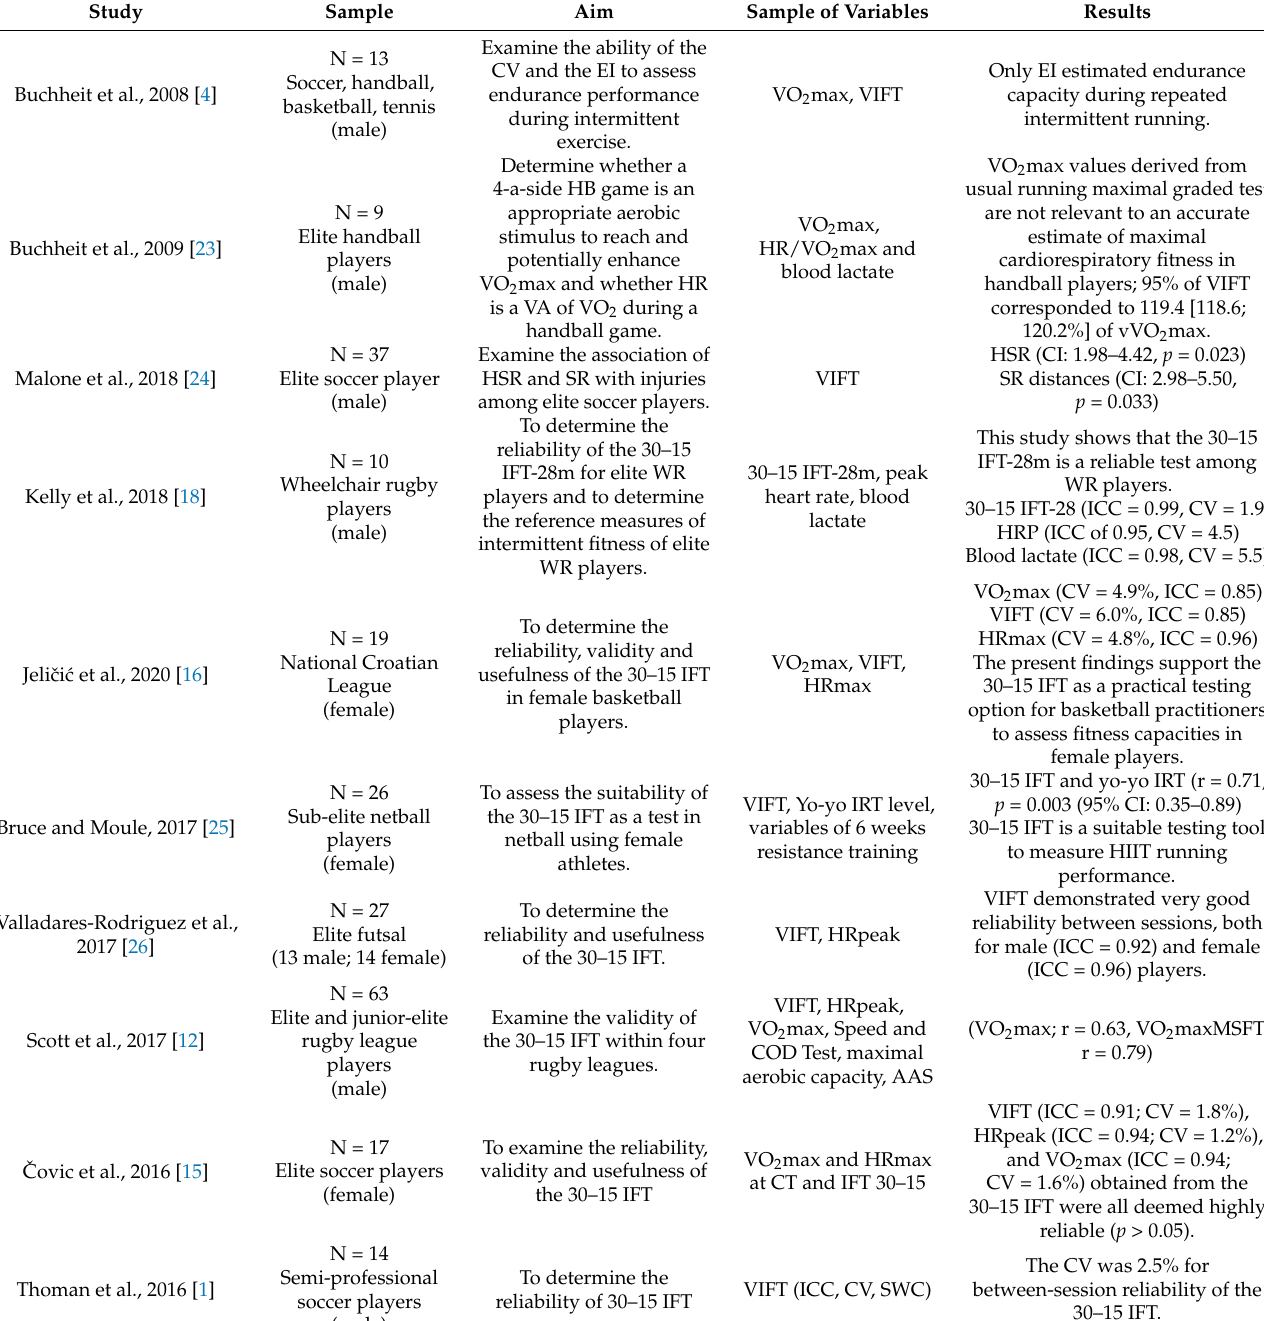
Table 3. Research studies where IFT 30–15 was used to verify validity, reliability and aerobic capacity